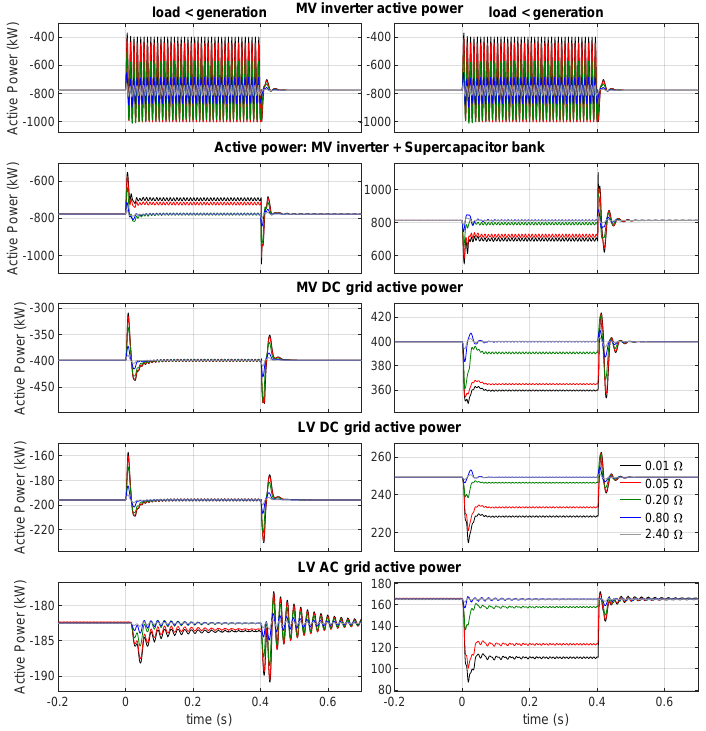
Figure 27. Active power in the ST’s MV inverter and hybrid AC/DC sub-networks following unbalanced phase-ground faults in the HV AC grid for the considered fault resistances.